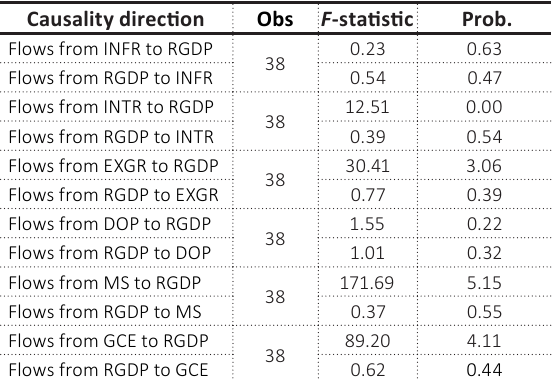
Table 7. Causality result